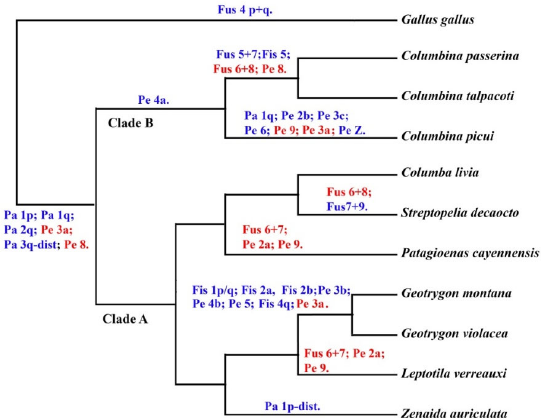
Figure 8. Chromosomal rearrangements in Columbidae species detected by chromosome painting using Gallus gallus and Zenaida auriculata probes and G-banding plotted in a molecular phylogeny [2]. Characters in red indicate chromosome rearrangements shared for more than one branch (homoplasic characters). Published chromosome painting data from Kretschmer et al. [10] and the data obtained in this study were used for this